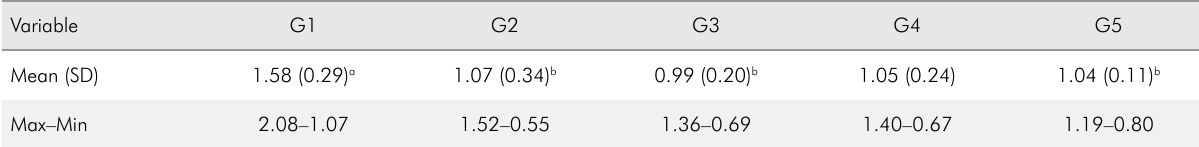
Table. Means, standard deviations (DP), and maximum and minimum values (kN) for dental crown fractures.